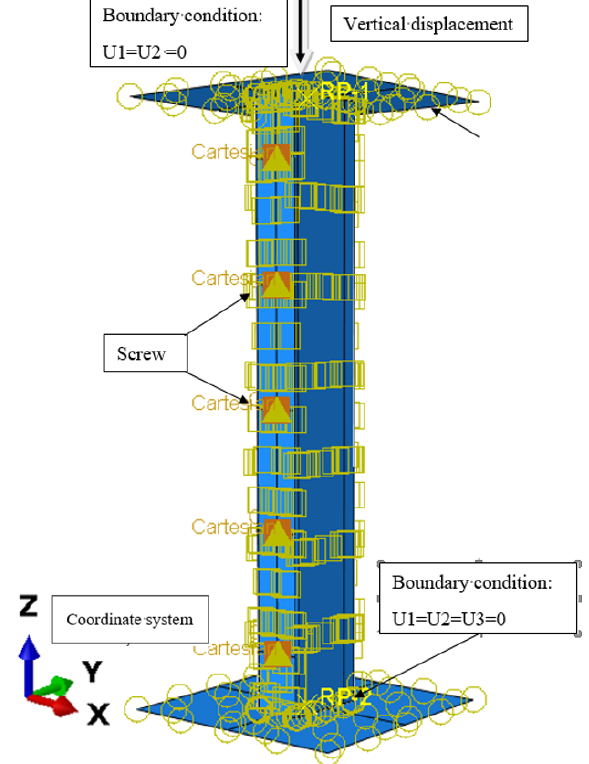
Figure 3. Boundary condition applied to the FE model of BL-L500-t1-S5.